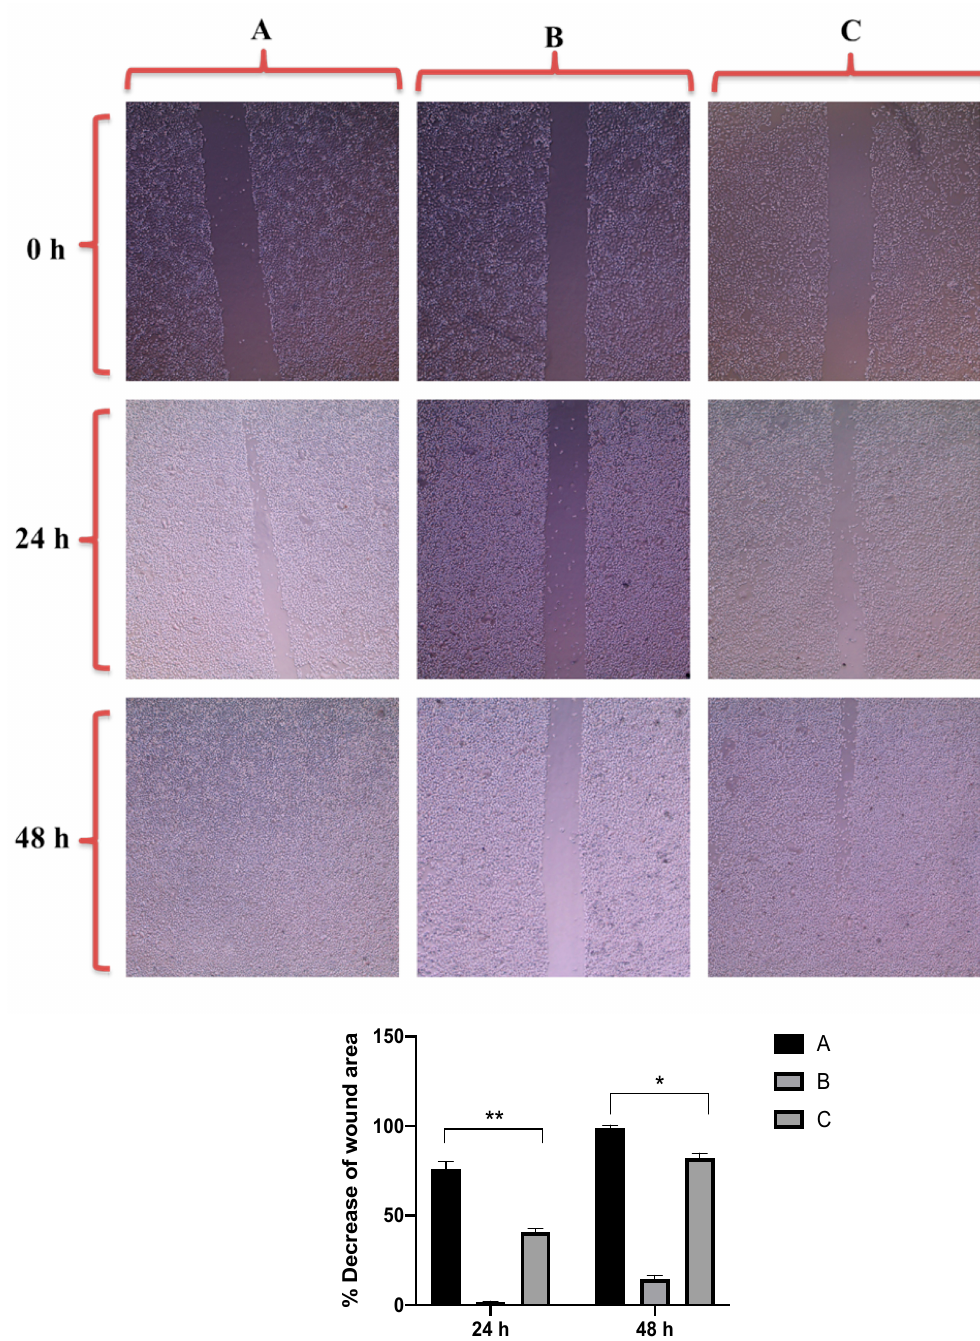
Figure 8. Up: In vitro cell migration of DU-145 cell line (control untreated cells) ( A ), upon treatment with positive control (quercetin) ( B ), and upon treatment with GNRs-PDA ( C ). Magnification power: 10×. Down: The percentage decrease in wound area was estimated using ImageJ. Data are represented as mean ± standard deviation (SD), n = 3. t -test was employed for the difference assessment; * p < 0.05, ** p < 0.01.